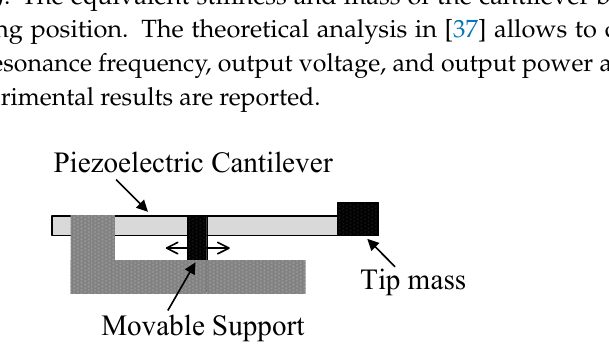
Figure 19. Schematic representation of the clamp position change based MTT proposed in [37].